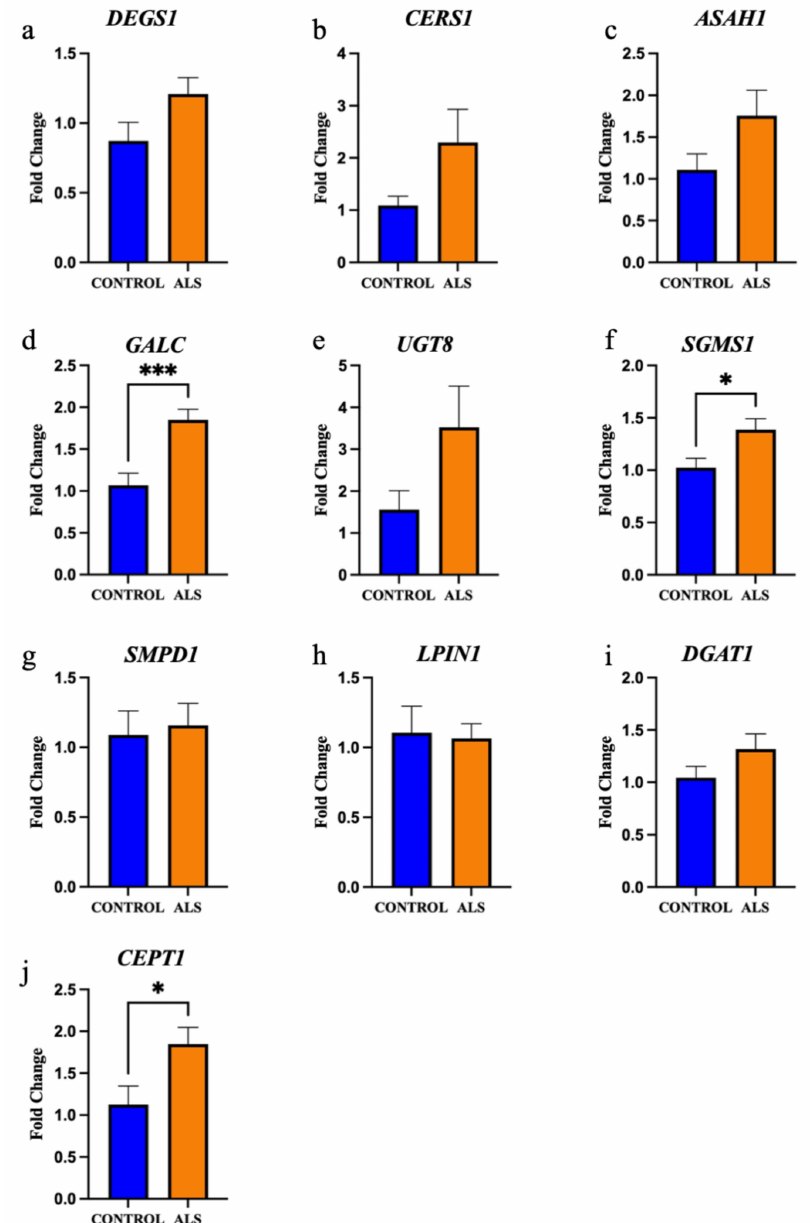
3’-phosphodiesterase (CNPase; Figure 7c; p = 0.76), myelin oligodendrocyte glycoprotein (MOG; Figure 7d; p = 0.051), myelin associated glycoprotein (MAG; Figure 7e; p = 0.74), PLP (Figure 7f; p = 0.054) or DM20 (Figure 7g; p = 0.065) levels. There was also no difference in the proportion of OLIG2-positive oligodendrocytes in the motor cortex white matter (Supplementary Materials, Figure S5; p = 0.52).